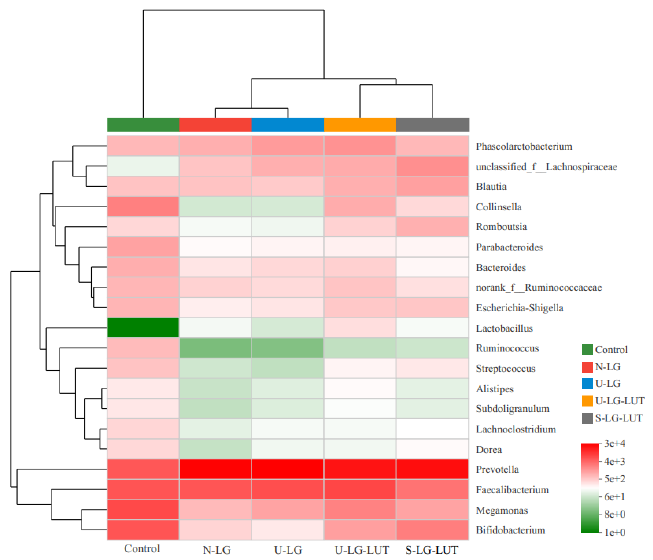
Figure 6. Effect of N-LG, U-LG, S-LG – LUT and U-LG – LUT on the community heatmap analysis at the genus level.